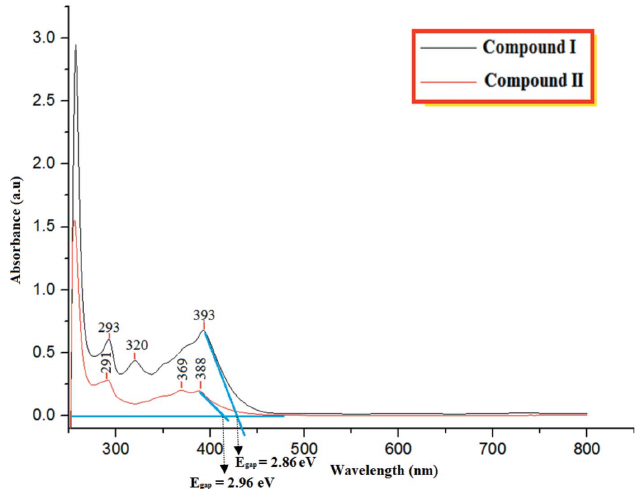
Figure 3 The UV–Vis absorption spectra of compounds I and II